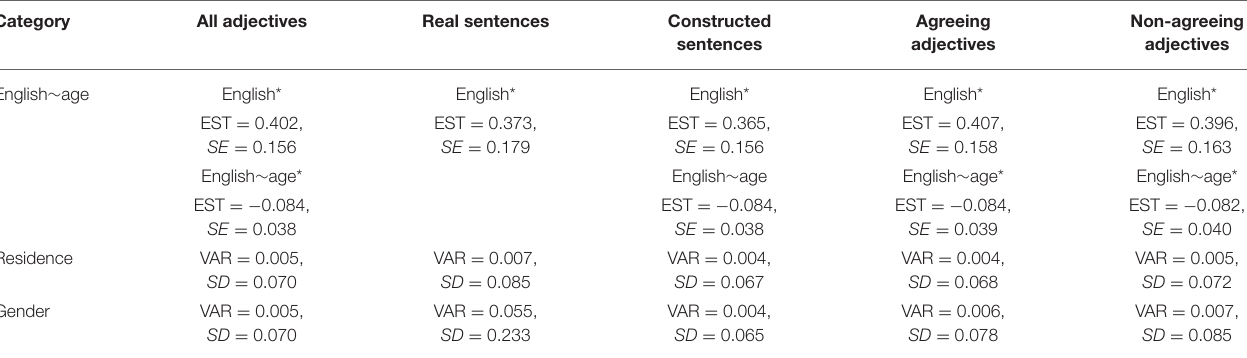
TABLE 4 | Regression results between acceptability rates across adjective types and two factors: proficiency in/exposure to English and age.